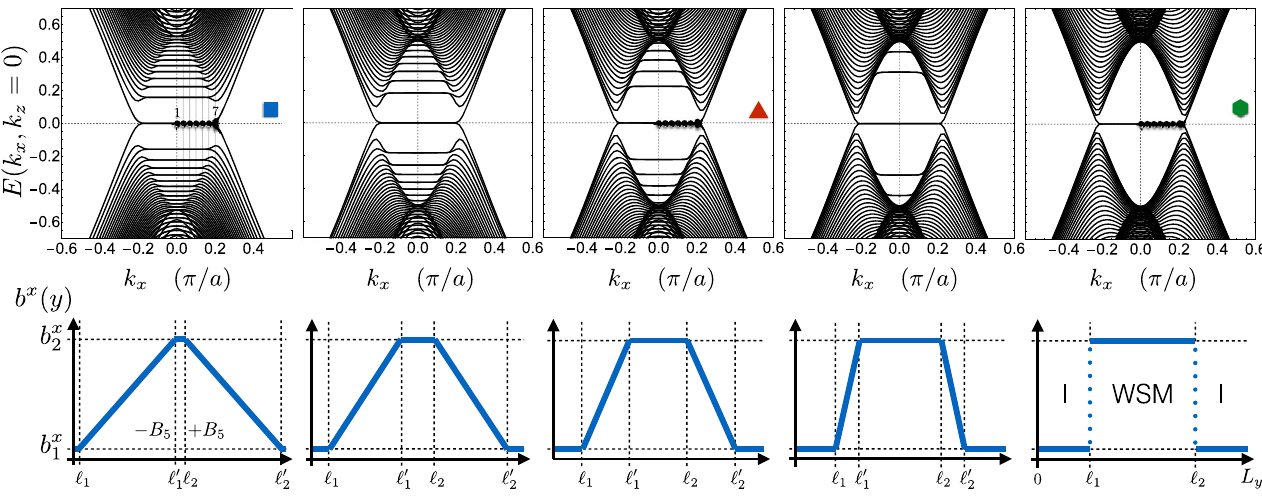
FIG. 1. The top row shows the energy spectra obtained by solving Eq. (28) in the presence of a spatially varying b x ¼ b x ð y Þ , as a 0 . The schematic profile of b x ð y Þ corresponding to each spectrum is presented below the energy panel. From function of k and for k x z ¼ left to right, the region of linear increase (decrease) of b x , set by l 0 1 − l 1 ( l 0 2 − l 2 ), gradually shrinks and becomes an abrupt stepwise increase (decrease) at l 1 ( l 2 ). The latter case describes an interface between an insulator (I) and a Weyl semimetal (WSM) (all spectra are calculated for m ¼ 0 . 5 ), and the energy spectrum exhibits the zero-energy Fermi arc surface states connecting the bulk nodes. The panel on the left shows the pseudo-Landau-level structure of the low-energy states, arising as a result of a bulk axial magnetic field B z 5 ¼ (cid:2) B 5 . As l 1 0 − l 1 ¼ l 2 0 − l 2 is decreased from left to right, the strength of the axial magnetic field is increased and the n ≥ 1 pseudo-Landau ffiffiffiffiffiffiffiffi p nB 5 levels (energy scales as ∼ ) are pushed out of the spectrum. The n ¼ 0 , however, remains at E ¼ 0 and morphs into the Fermi arc associated with the boundary surface shared by I and WSM. In these calculations ð b x 1 ¼ 0 . 0 ; b x 2 ¼ 1 . 0 Þ , − l l − l 80 ; 60 ; 40 ; 20 Þ , ð l l 45 ; 135 Þ (rightmost panel), with system size L l 1 0 1 ¼ 2 0 2 ¼ ð 1 ; 2 Þ ¼ ð (all lengths measured in units of lattice constant a ). The solid black dots in the upper panels indicate the (zero-energy) states for which the wave-function support is shown in Fig.